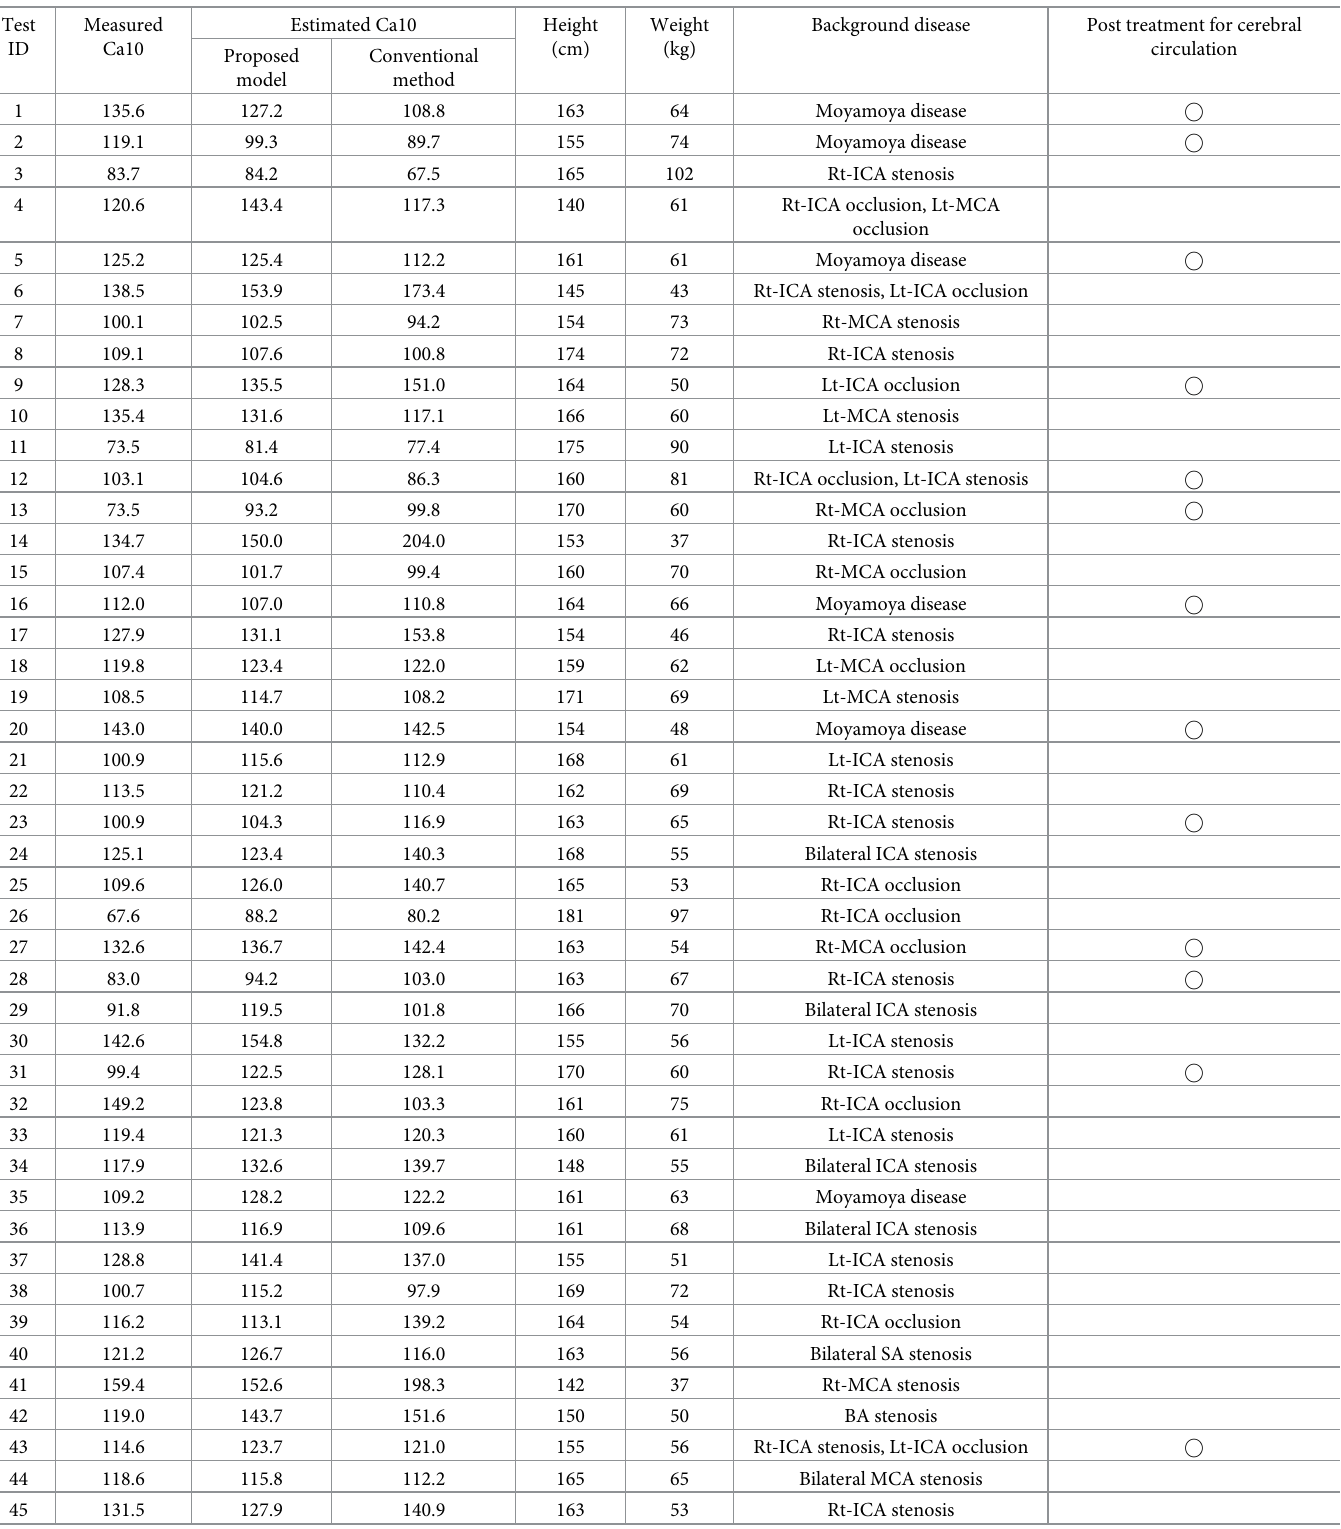
Table 1. The measured and estimated values of the Ca10 in testing